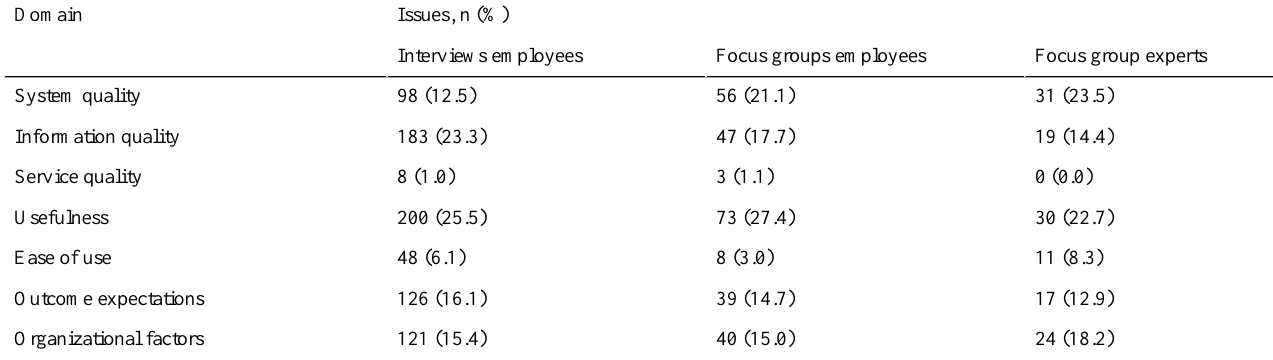
Table 3. Overview of issues per domain (number and